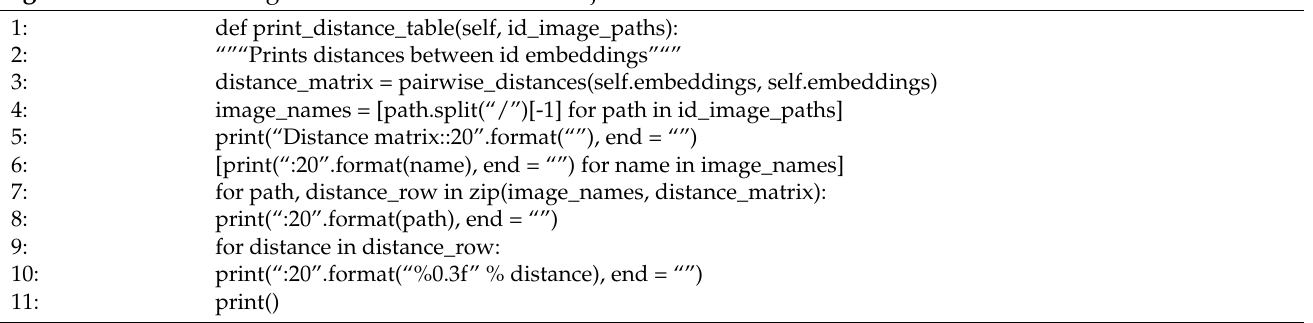
Algorithm 2 Determining the distance between the object and the camera